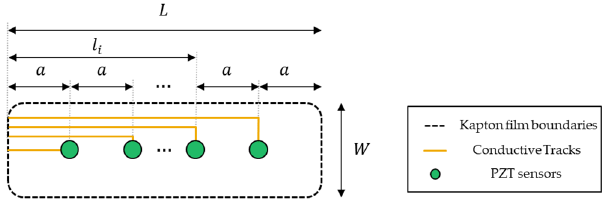
Figure 4. Geometry of the generic diagnostic film configuration for the estimation of the total track length required during printing.